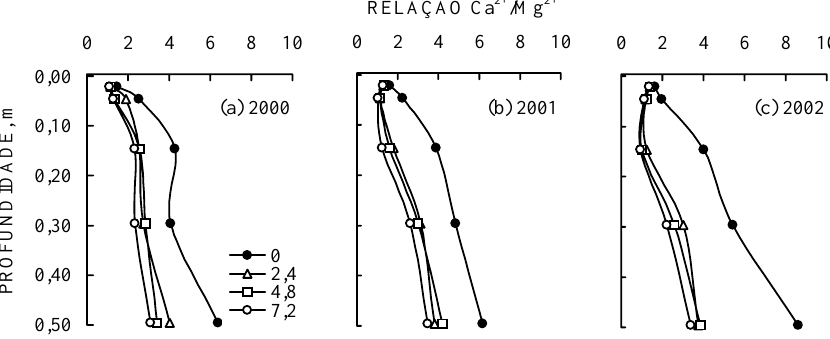
Figura 9. Relação média entre os teores de Ca 2+ e Mg 2+ de acordo com a profundidade de solo nas camadas intermediárias de 0–0,05, 0,05–0,10, 0,10–0,20, 0,20–0,40 e 0,40–0,60 m de profundidade, paras as doses de 0, 2,4, 4,8 e 7,2 t ha -1 de calcário distribuído na superfície do solo em 1999, para as amostragens de solo realizadas em 2000 (a), 2001 (b) e